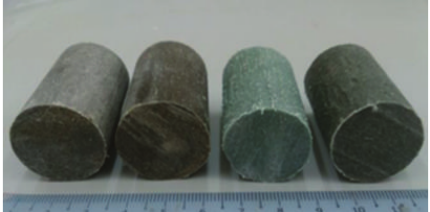
Figure 1: Bioplastic fertilizer (BpF) composites.